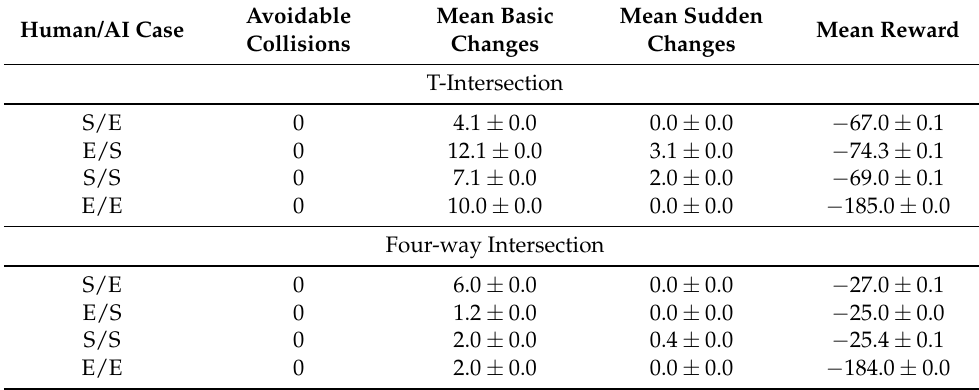
Table 12. Human: sensor and mask, AI: color. Test results for manager performance and behavior.